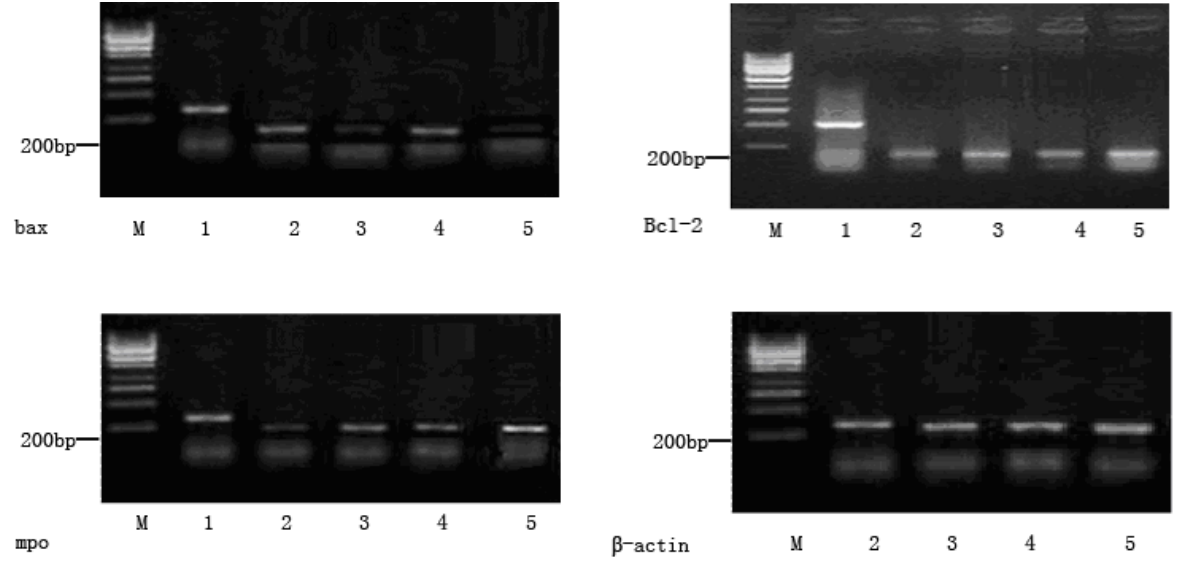
Figure 2: The change of cell gene expression after 72 hours’ culture. M: marker 1-β-actin 2: Hss group 3: As2O3 group 4:tretinoin group 5: control